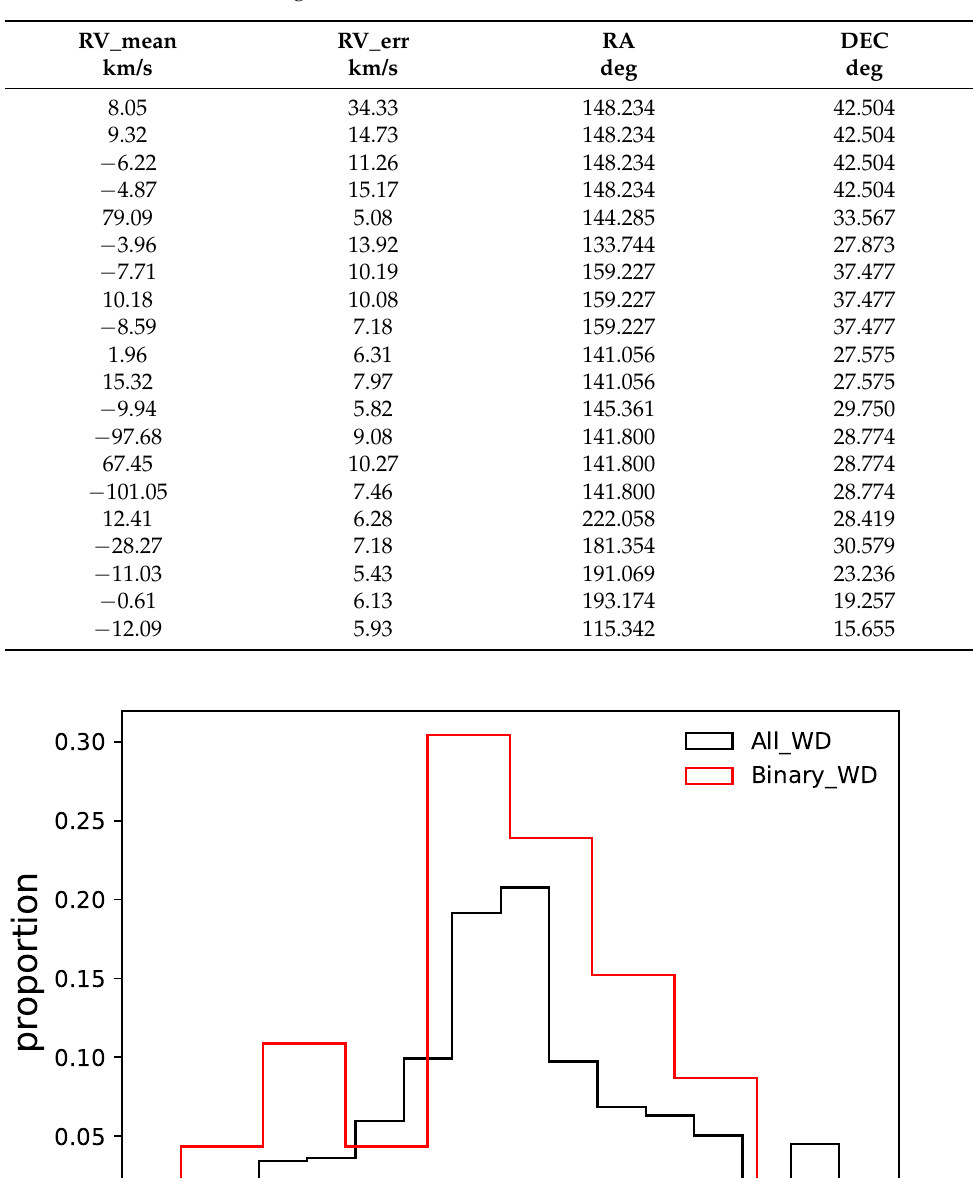
Table 2. RVs of these homologous WDs.